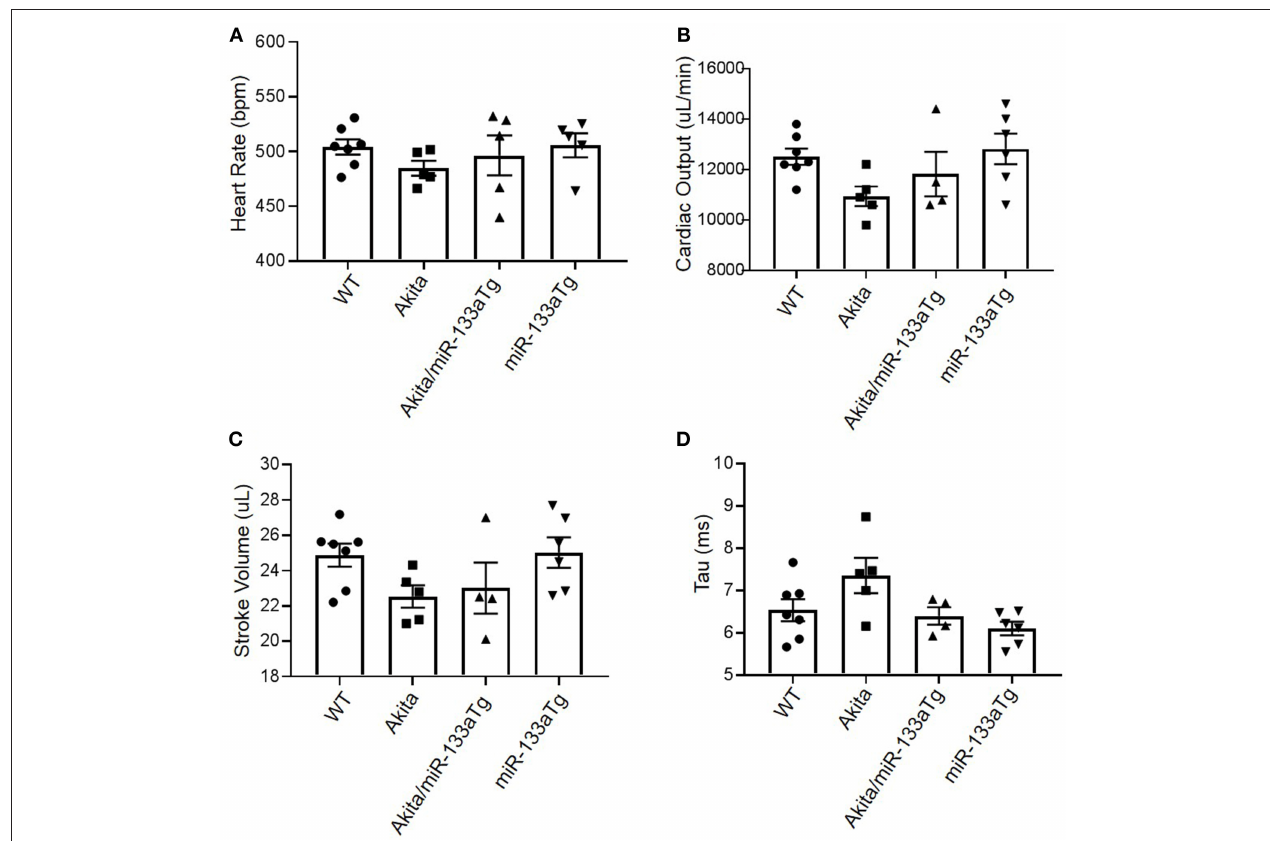
FIGURE 6 | Pressure-volume (P-V) loop study for hemodynamic analysis. (A) The heart rate of mice from WT, Akita, Akita/miR-133aTg, and miR-133aTg group. (B–D) Cardiac output, stroke volume, and Tau in WT, Akita, Akita/miR-133aTg, and miR-133aTg mice. Values are presented as mean ± SEM. N = 4–7 per group. One-way analysis of variance (ANOVA) and Tukey’s test were